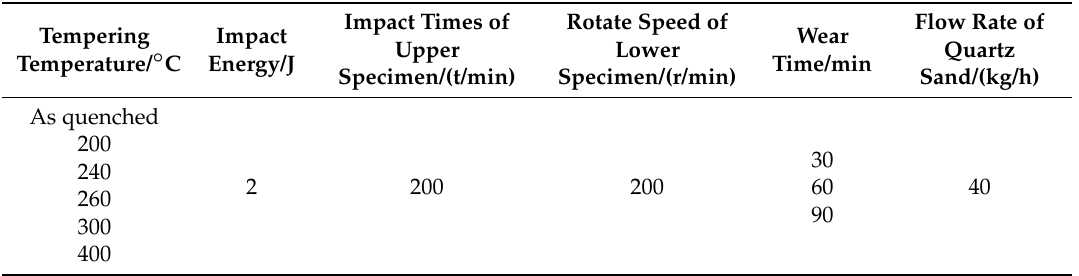
Figure 1. Schematic illustration of MLD-10 impact wear resistance test equipment. Table 2. Experimental program of impact wear resistance tests.